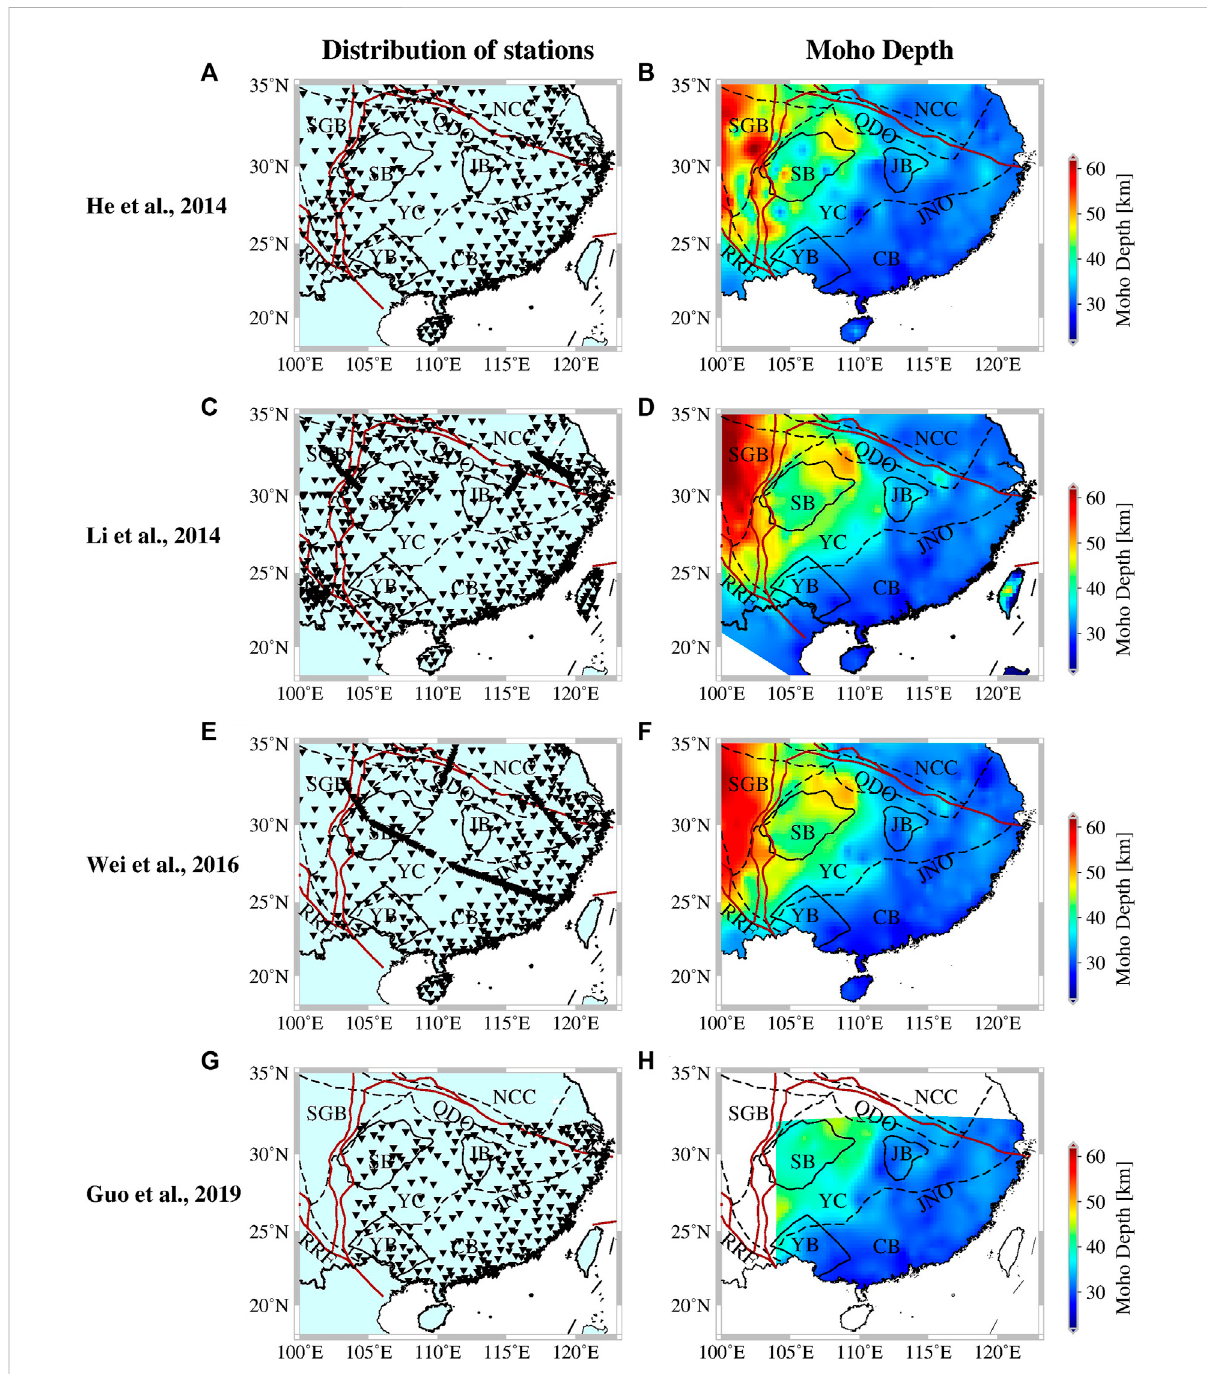
Distribution of stations and the Moho depth maps from different studies. (A,B) The He et al. (2014) model, (C,D) the Li et al. (2014) model, (E,F) the Wei et al. (2016) model, (G,H) the Guo et al. (2019)